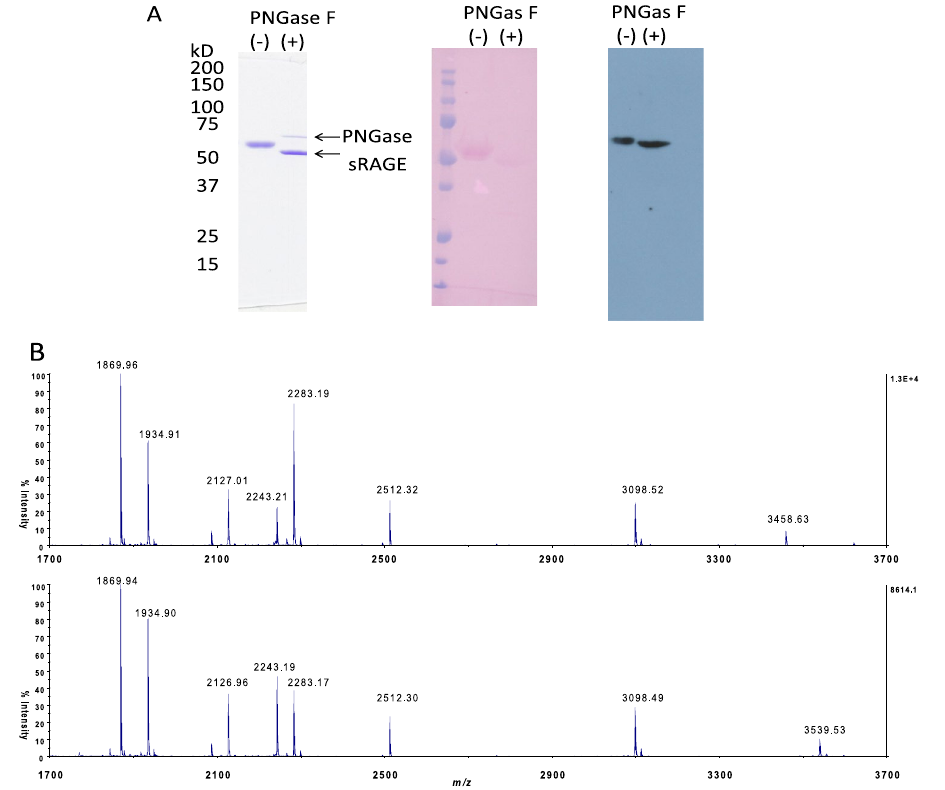
Figure 3. Analysis of glycosylation. ( A ) Left panel: CBB staining of 12% gels of sRAGE with ( + ) or without ( − ) PNGase treatment. Central panel: glycoprotein staining. sRAGE proteins with or without PNGase treatment were separated with SDS-PAGE, followed by blotting to nitrocellulose membranes and glycoprotein staining. Right panel: detection with anti-RAGE antibodies. ( B ) MALDI-TOF mass spectra of trypsin-digested sRAGEs without (upper panel) and with PNGase F treatment (lower panel). The observed peaks were as follows: m/z 1870.0 for AVSISIIEPGEEGPTAGSR (315–333), m/z 2127.0 for LISEEDLNSAVDHHHHHH (416–433) and HPETGLFTLQSELMVTPAR (180–198), m/z 2243.2 for VLP N GSLFLPAVGIQDEGIFR (78–98 deamidation) and VLASEGQTVAAGEVLLILEAMK (351–372 deamidation), m/z 2283.2 for RHPETGLFTLQSELMVTPAR (179–198, deamidation), m/z 2512.3 for VYQIPGKPEIVDSASELTAGVPNK (117–140), and m/z 3539.5 for